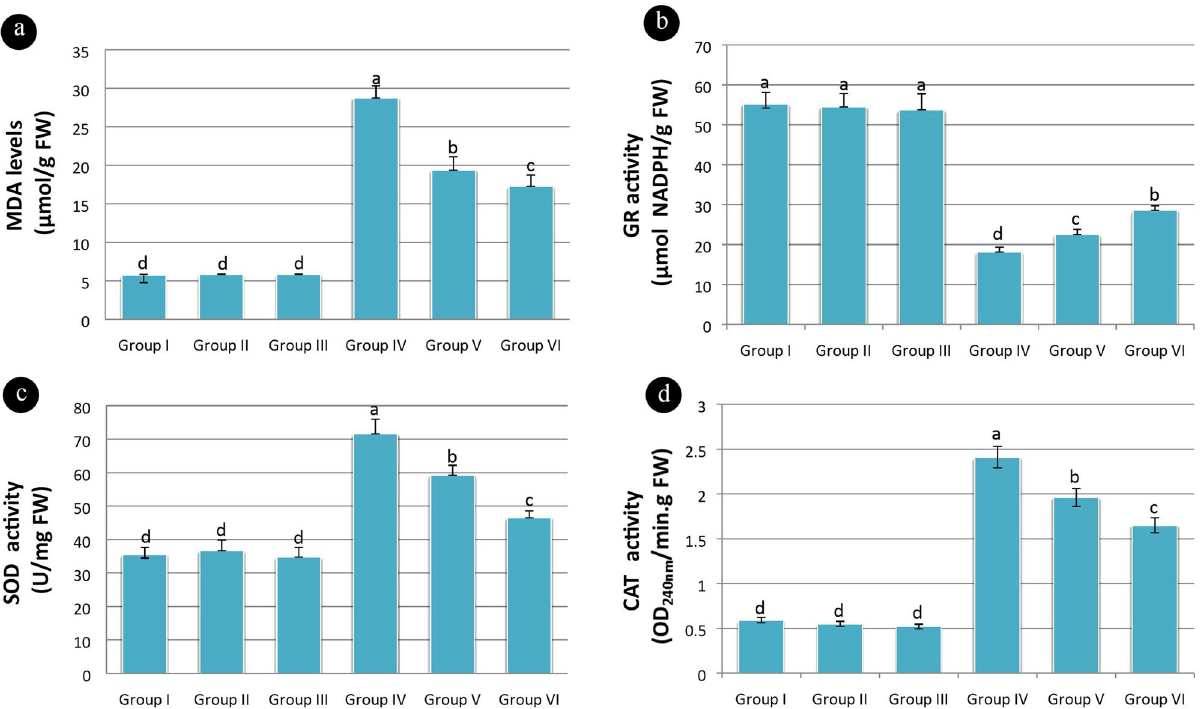
Figure 4. Effects of pendimethalin and curcumin applications on lipid peroxidation and antioxidant enzyme activities ( a : MDA levels, b : GR levels, c : SOD levels d : CAT levels) [Data were shown as mean ± SEM. The averages shown with different letters in each graph are statistically significant ( P <